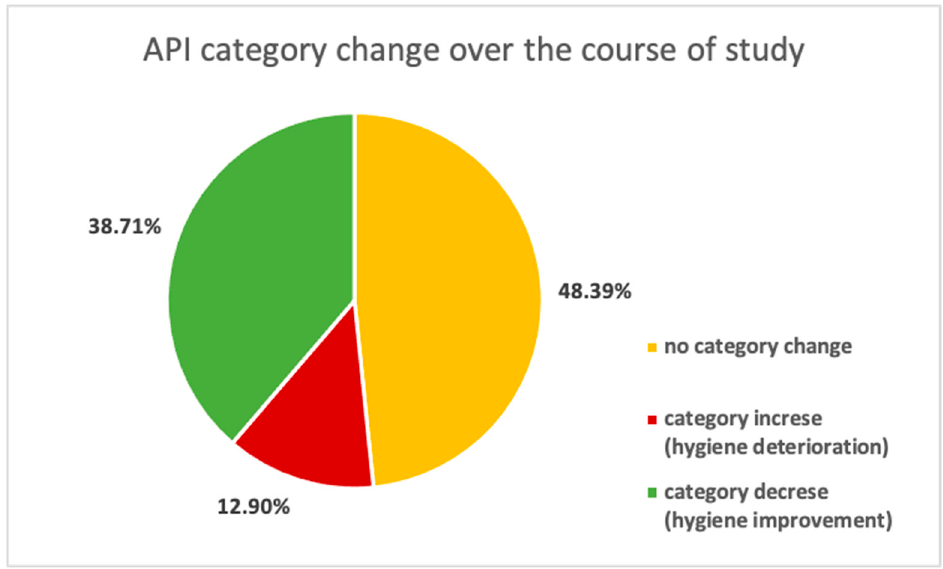
Figure 7. Participants’ potential API category change over the course of study.